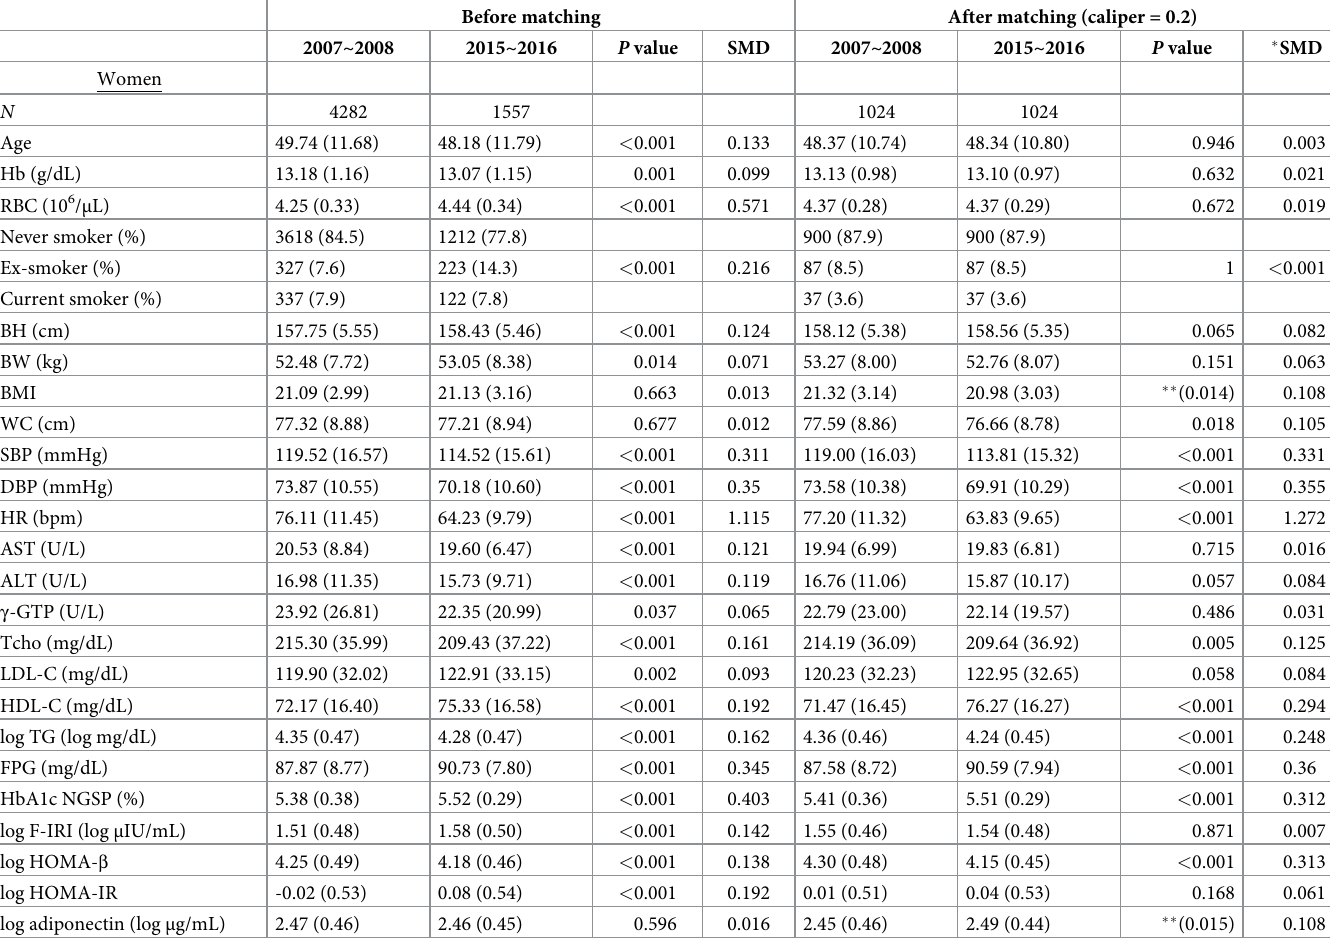
Table 2. Clinical characteristics and biochemical parameters of women without diabetes mellitus before and after pair-matching. Before